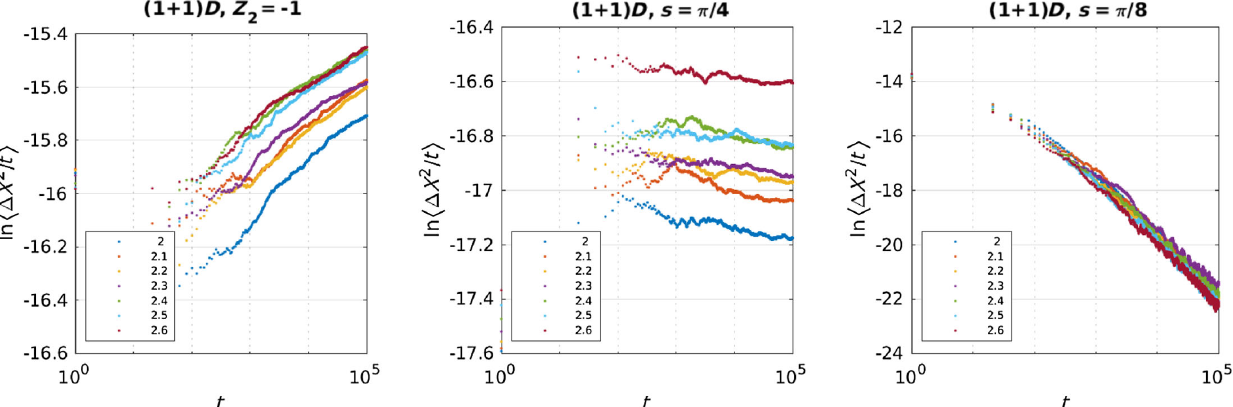
FIG. 5. Scaled width of a wave packet h Δ X 2 =t i for different quantum walks in ð 1 þ 1 Left panel: topological quantum walk showing anomalous superdiffusion. Middle panel: critical quantum walk of a class-A model fine- tuned to a topological phase transition. Right panel: topologically trivial quantum walk subject to Anderson localization. Colors correspond to incommensurate frequencies ω 2 ¼